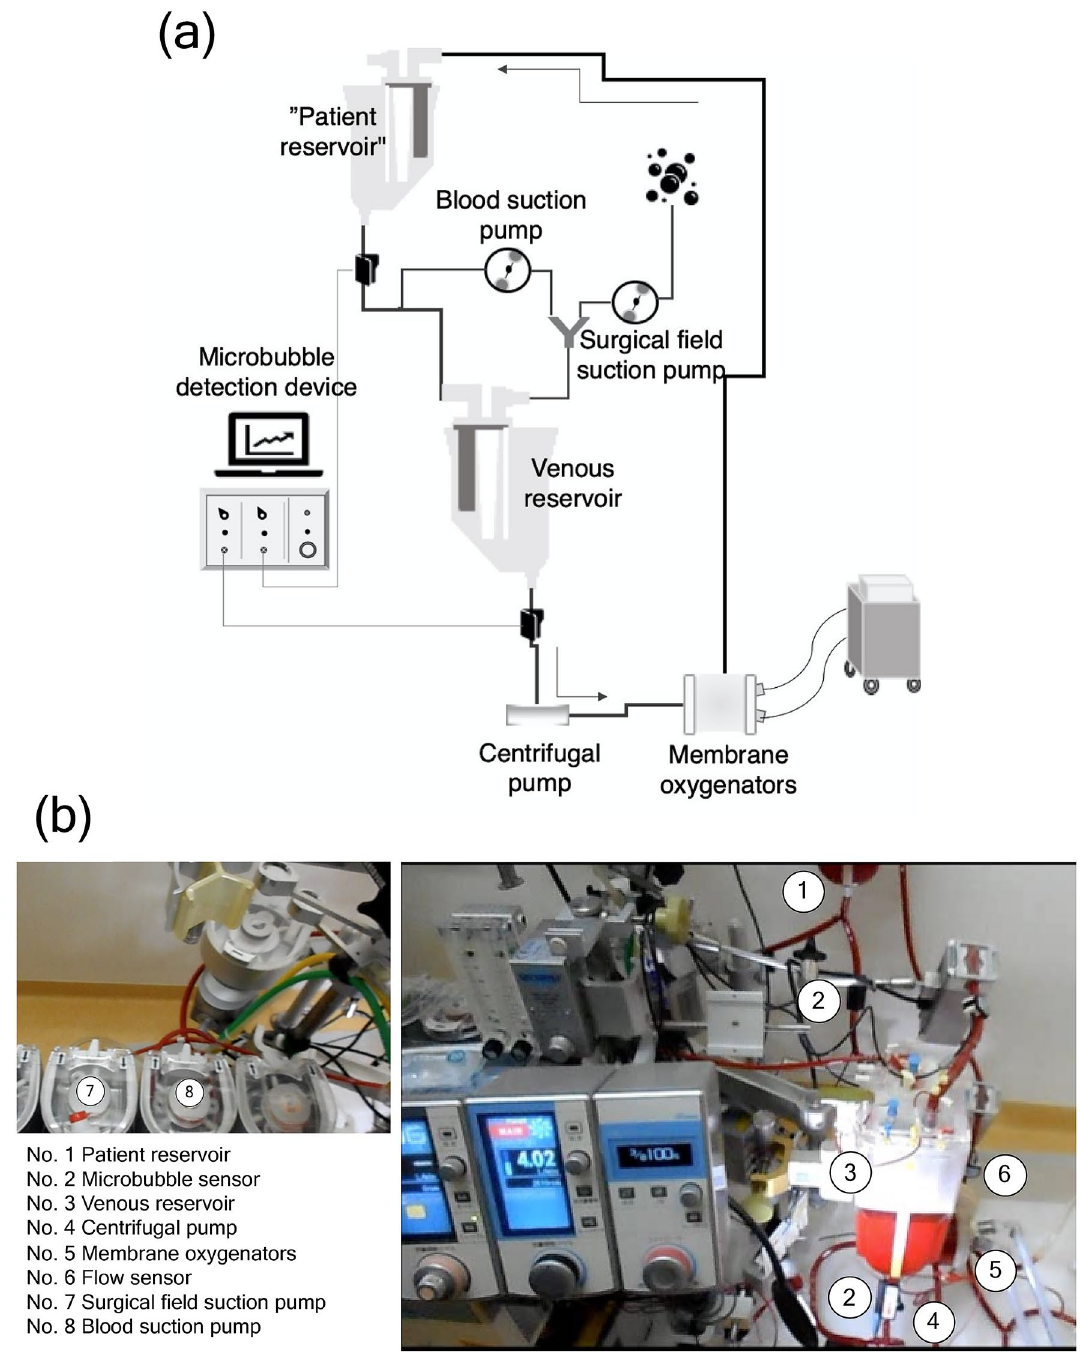
Figure 8. Experimental setup. ( a ) A schematic view, and ( b ) a photo. Given that the blood suction pump draws air, the pump adjusts the blood loss in the surgical field. In actual clinical practice, the surgical field (No. 7) and the blood suction pumps (No. 8) allow the estimation of the total aspirated flow rate in the operative field. Additionally, the microbubble sensor (No. 2) was installed to confirm that no air was mixed in the venous circuit from the patient reservoir, and the other microbubble sensor (No. 2) was attached to the bottom of the reservoir to measure the number of microbubbles. The blood was pumped by the centrifugal pump (No. 4), the flow rate was measured by the corresponding sensor (No. 6), and the blood was returned to the patient reservoir through the membrane oxygenators (No. 5). The patient reservoir was set up to regulate the circulating blood volume. It also contributed to the removal of